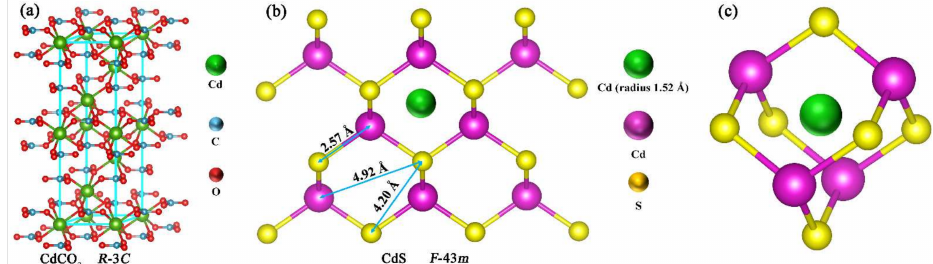
Figure 7. Crystal structures of CdCO 3 ( a ) and CdS ( b ). Cd 2+ (from CdCO 3 ) enters the unit cell of CdS and causes lattice distortion ( c